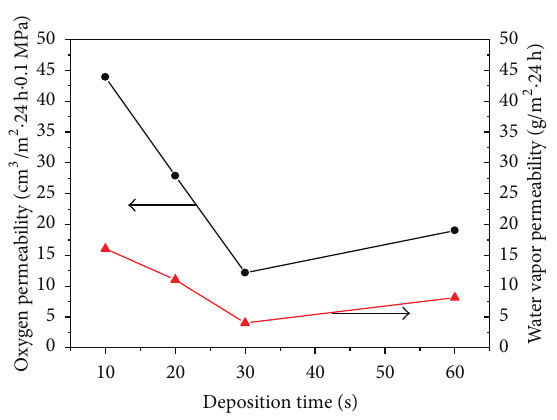
Figure 6: Barrier properties under different deposition time. Figure 7: Barrier properties under different RF